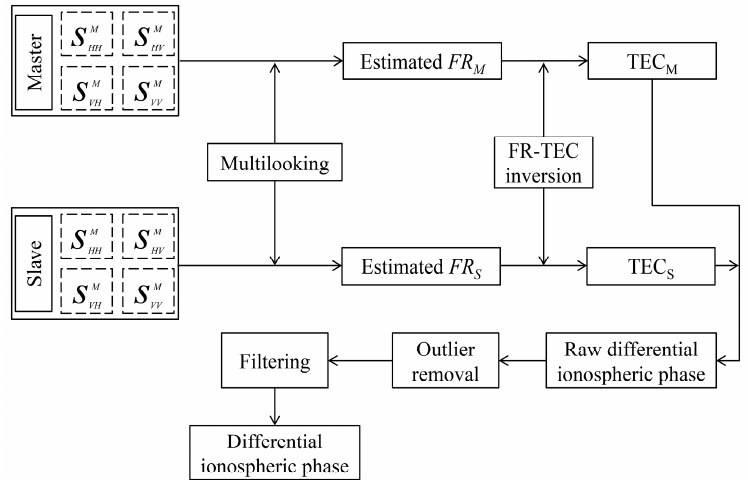
Figure 3. Schematic representation of workflow.